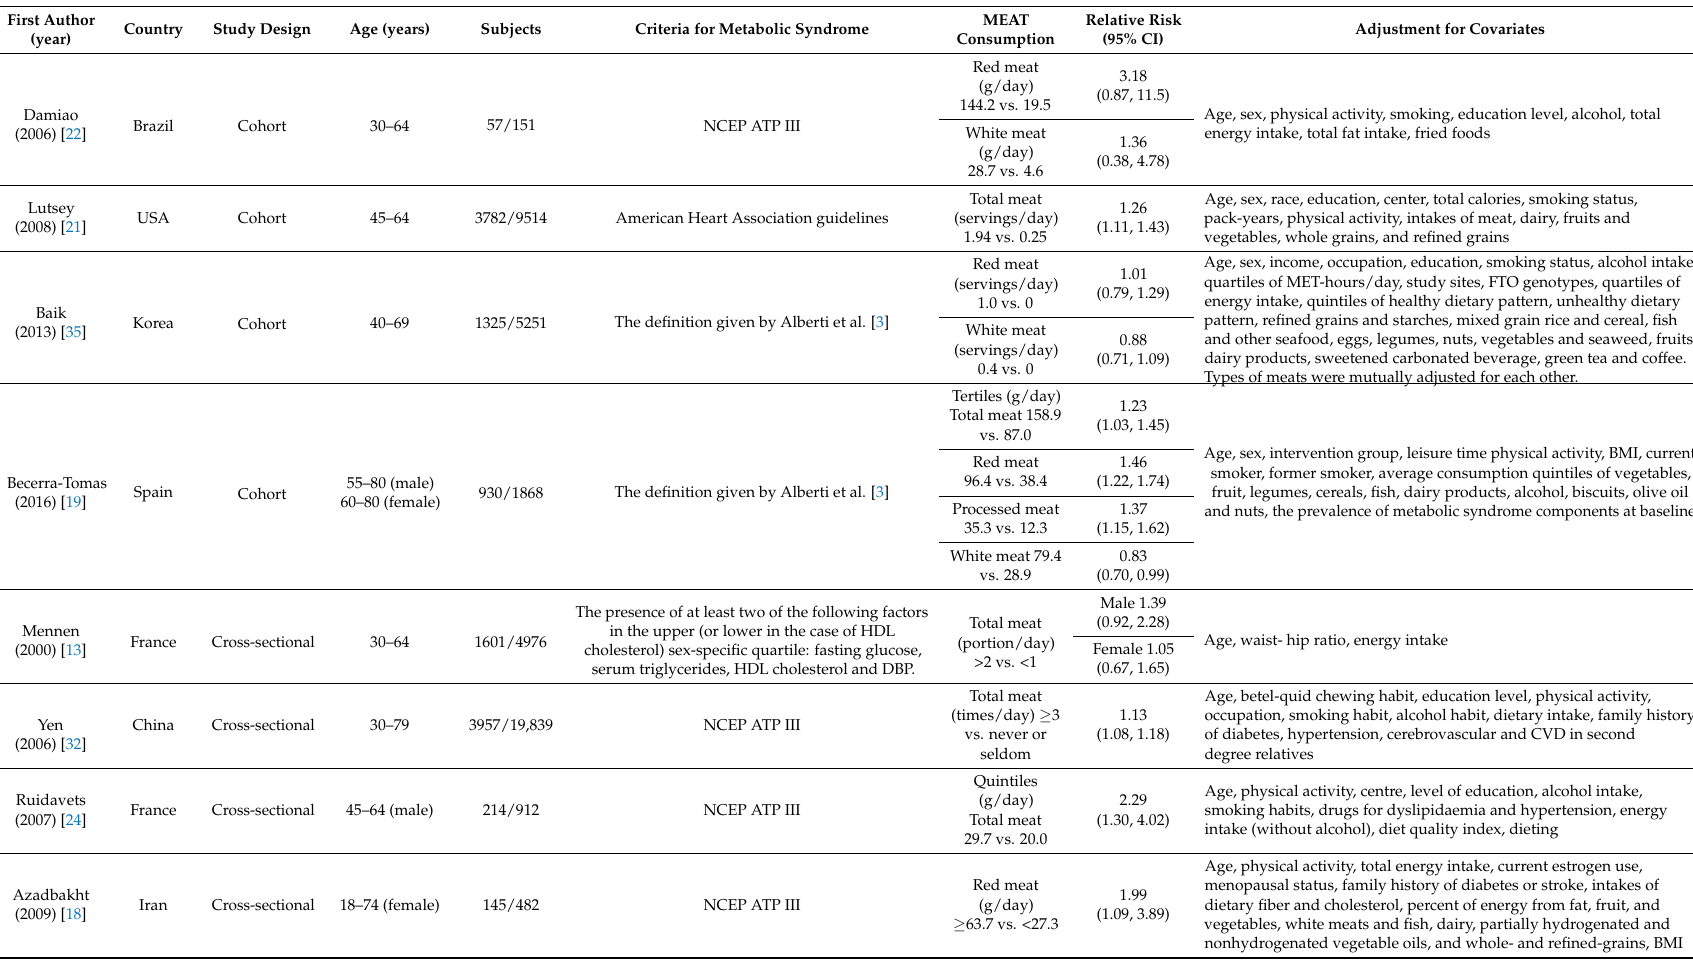
Table 1. Characteristics of epidemiological studies included in the meta-analysis of meat consumption and metabolic